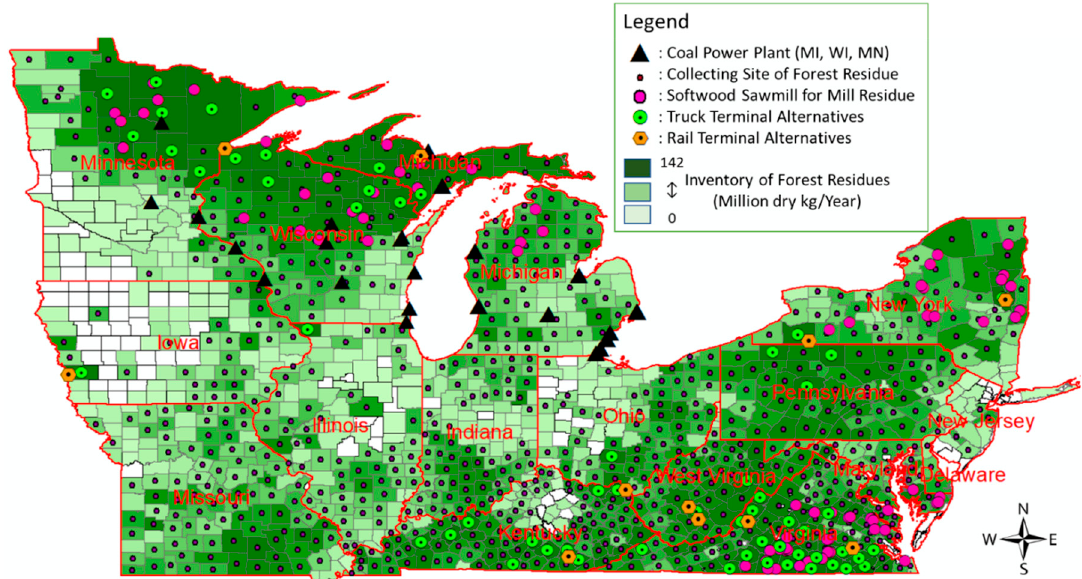
Figure 4. Feedstock locations, potential terminals, and target coal power plants in Michigan (MI), Wisconsin (WI), and Minnesota (MN).